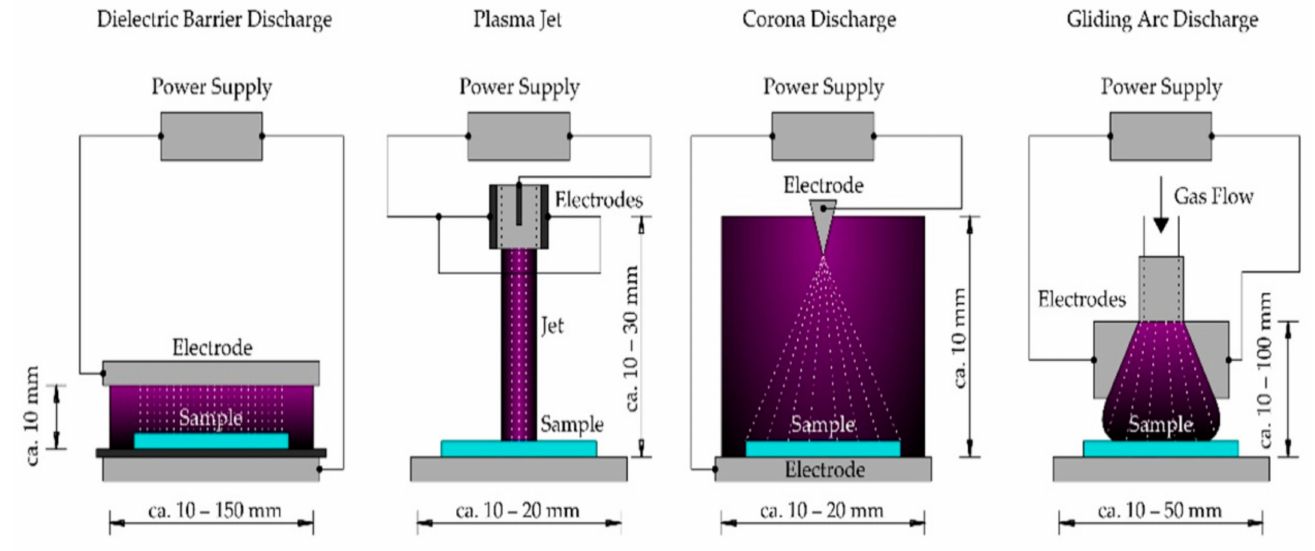
Figure 6. Schematic overview of cold plasma devices (adapted from Domonkos et al. [59] with permission).